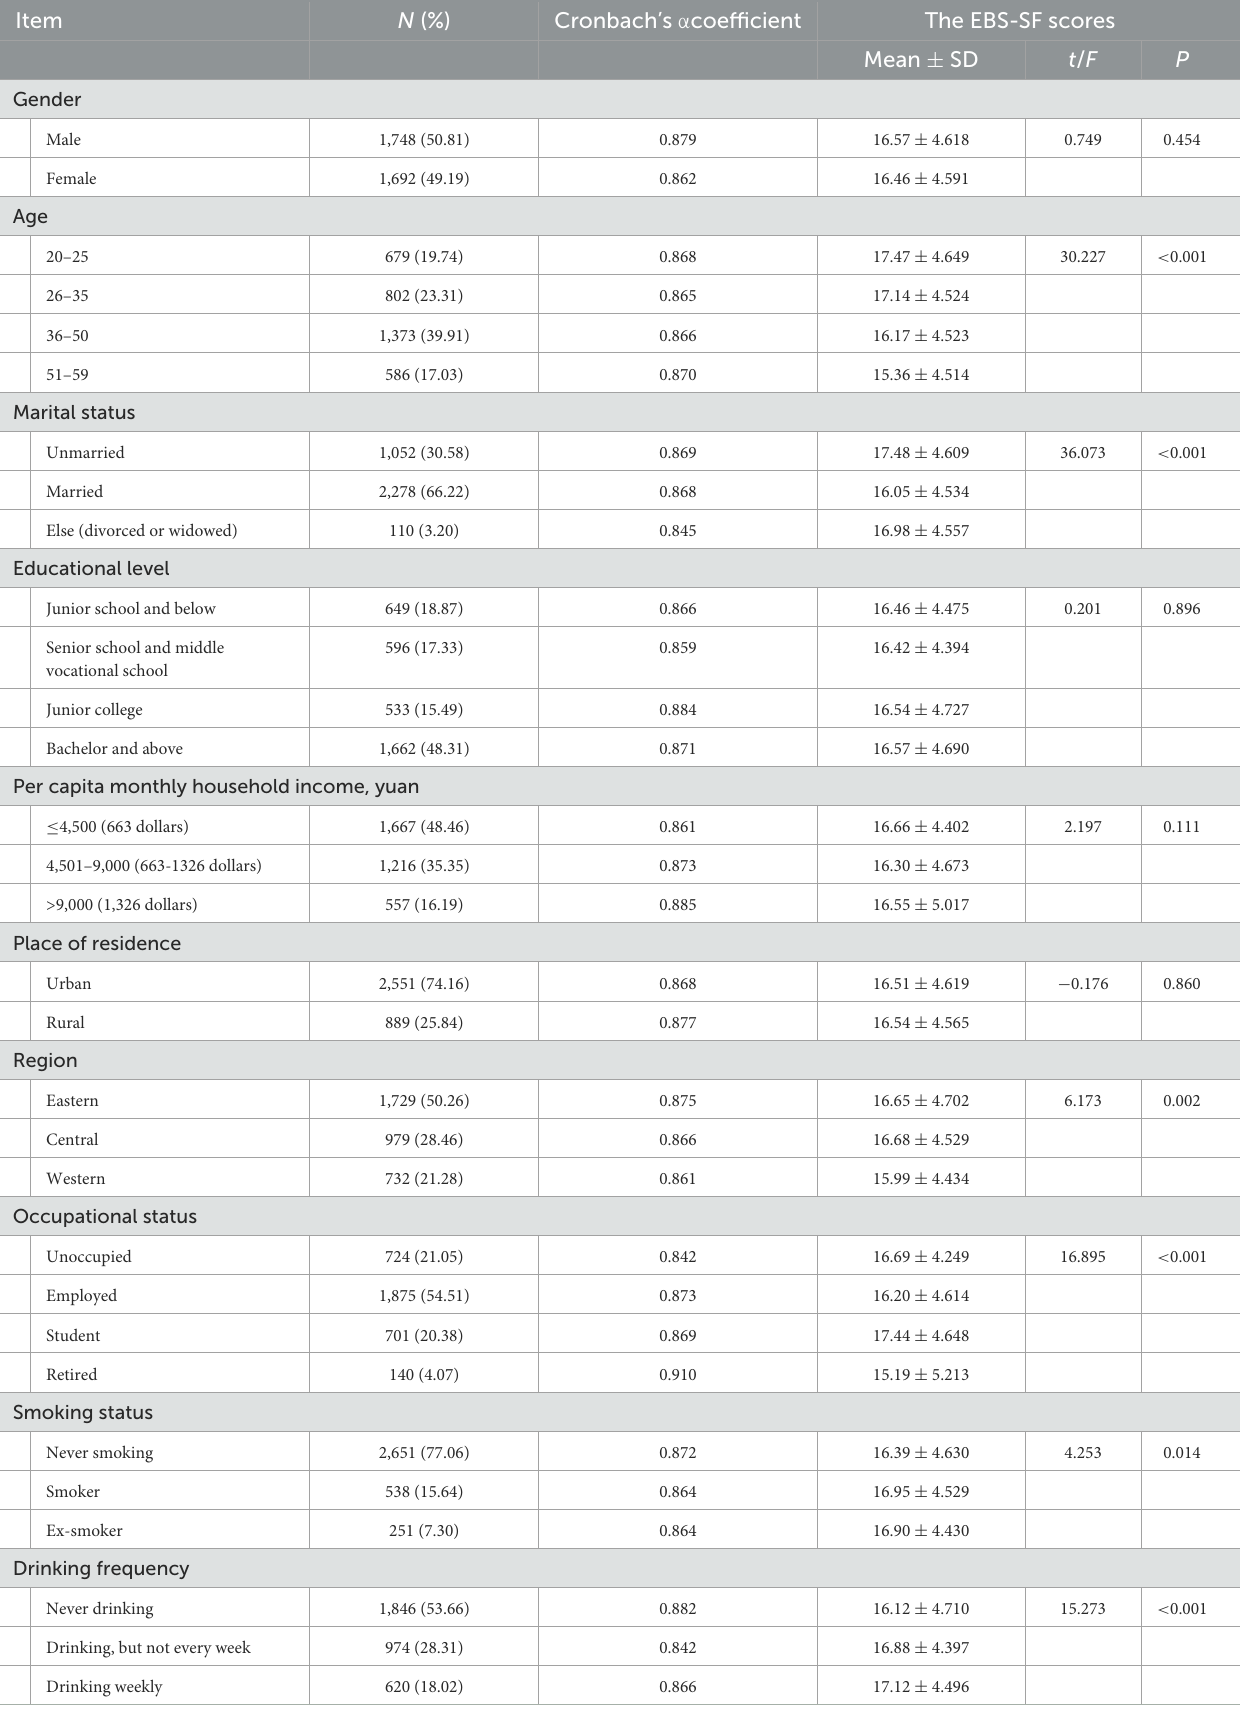
TABLE 1 Sociological characteristics of the participants, the score of the EBS short form and Cronbach’s coefficients for each